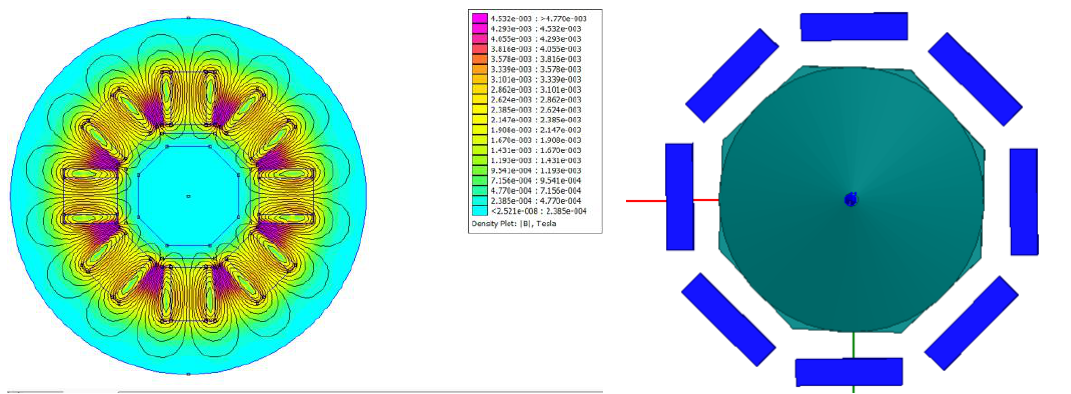
Figure 2. Flux lines flow in MFEML (top